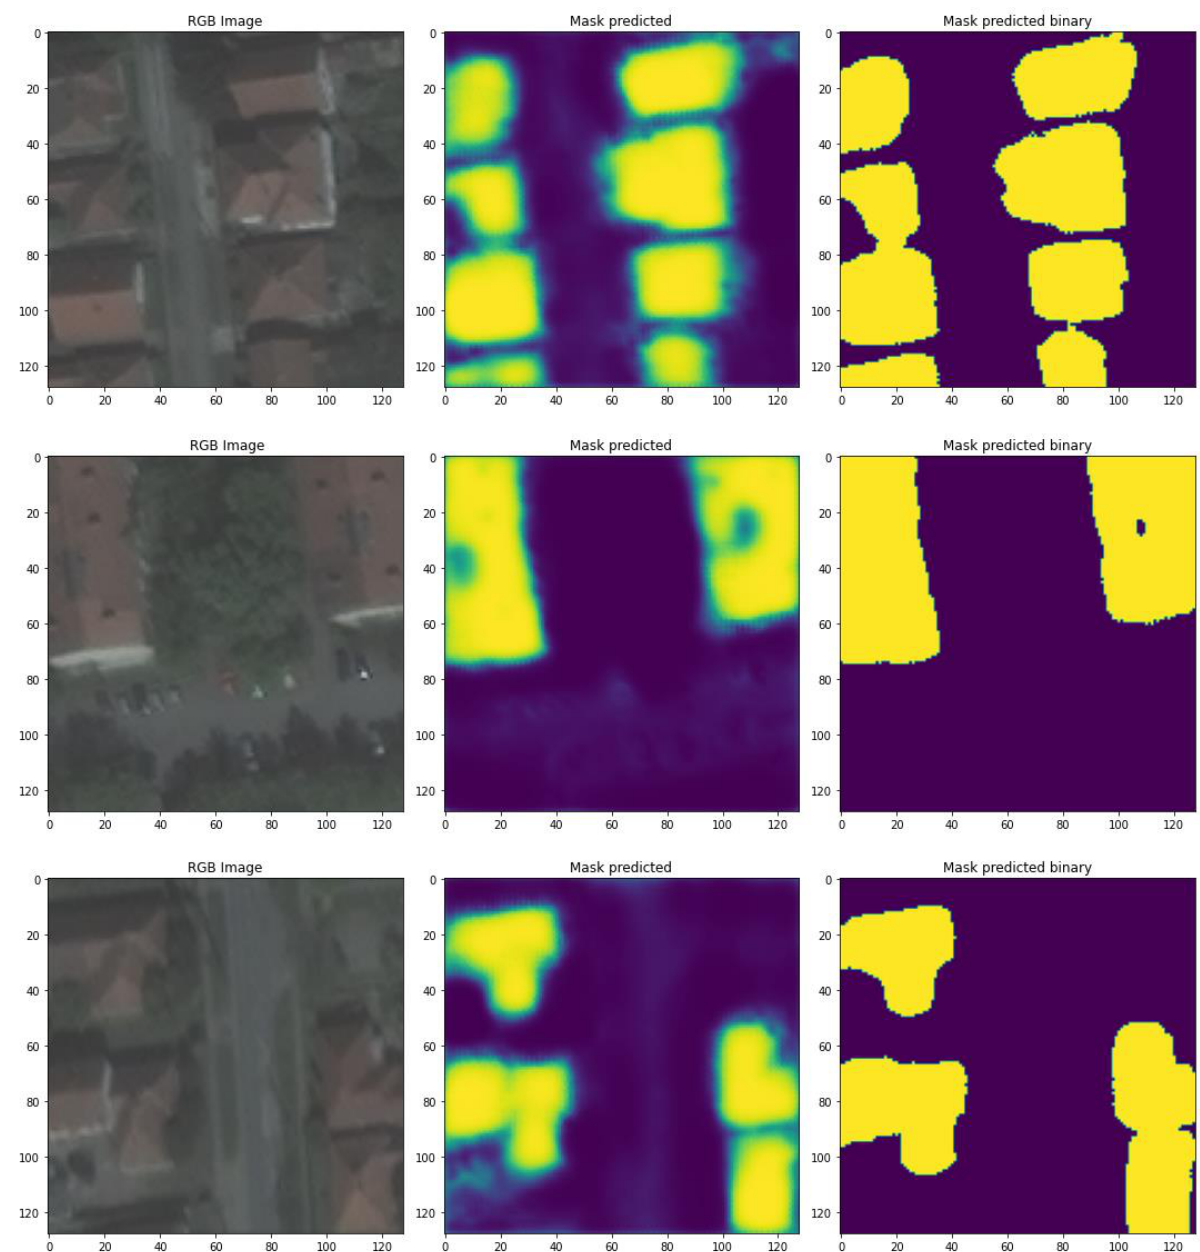
Figure 16. Examples of object identification without ground truth data—Zrenjanin.